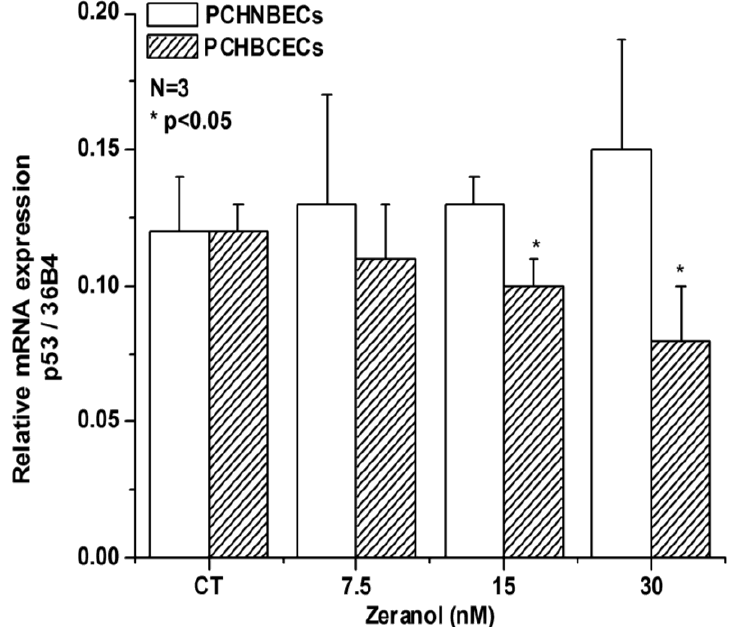
Figure 2. Comparison of effect of Z on the expression of p53 mRNA in PCHNBECs and PCHBCECs. PCHNBECs and PCHBCECs (1 × 10 5 cells/well) were seeded in 6-well plates and treated with 0.1% DMSO, 7.5, 15, and 30 nM Z. After 24 h treatment, total RNA was isolated from each treatment group and RNA concentrations were